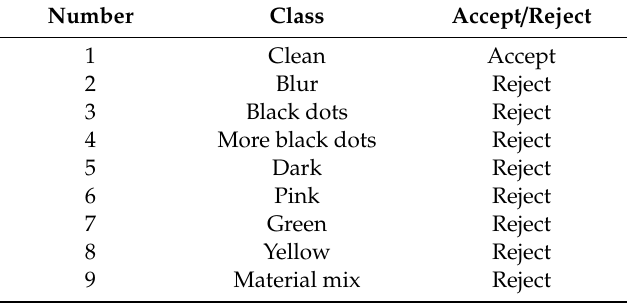
Table 1. List of used